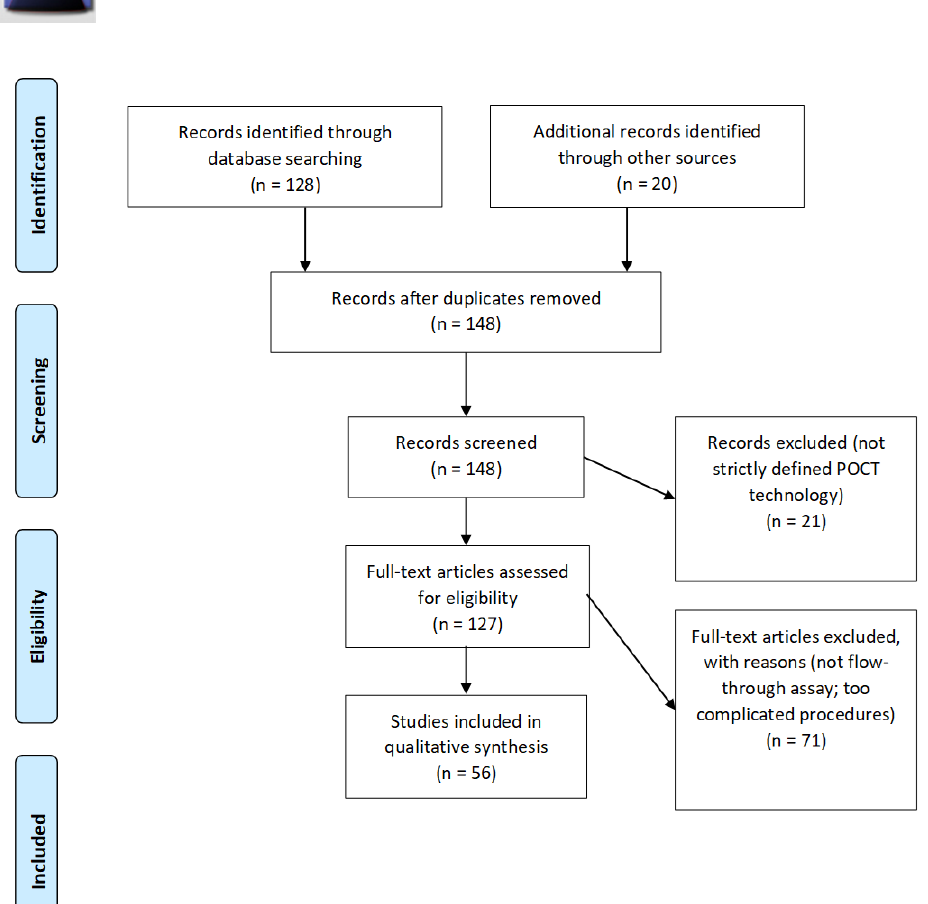
Figure 1. PRISMA flow chart of search methods used in this study. PubMed search was conducted on 1 August 2021 to gather relevant papers, using the following search strings: “Vertical flow assay”, “Flow through”, “point of care”. Vertical flow assay studies that met at least one of the World Health Organization (WHO) point of care testing (POCT) criteria were selected for review. Following these steps, a total of 56 studies that met these criteria were included in this